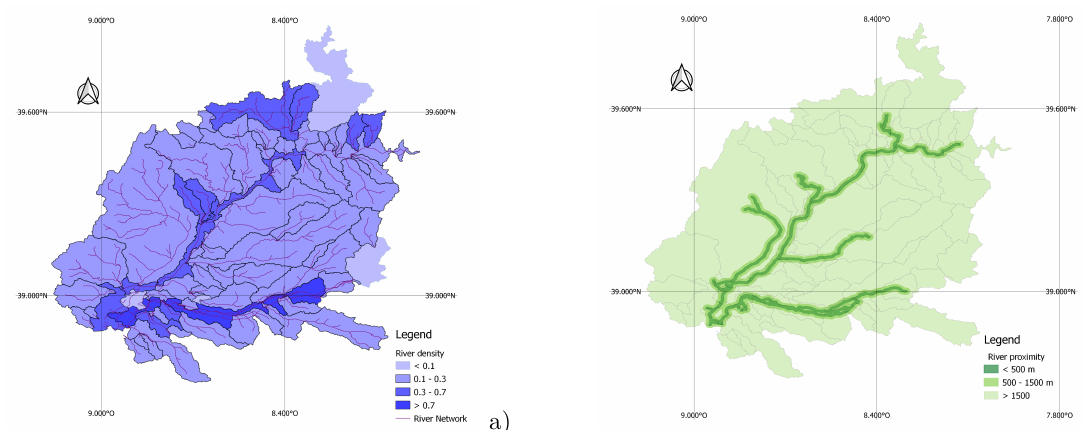
Figure 10. Data collection of vulnerability factors: a) River density and b) River proximity.